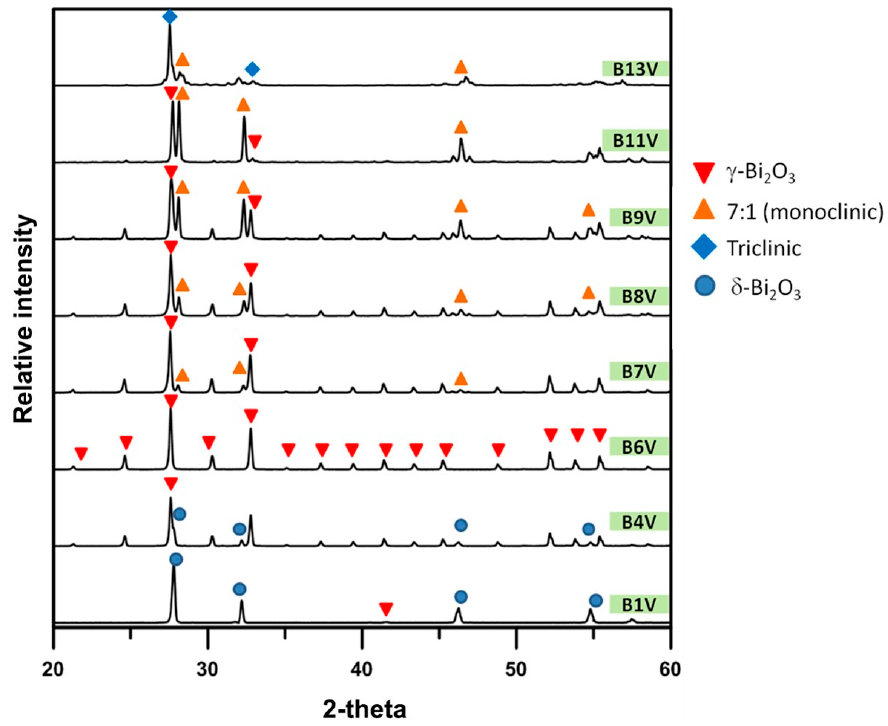
Figure A2. XRD patterns of B1V to B13V die-pressed mixtures, annealed at 740 °C for 100 h.